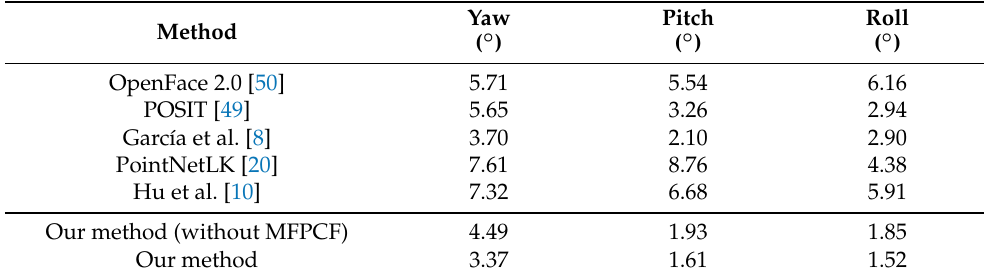
Table 3. Comparison of different head pose estimation